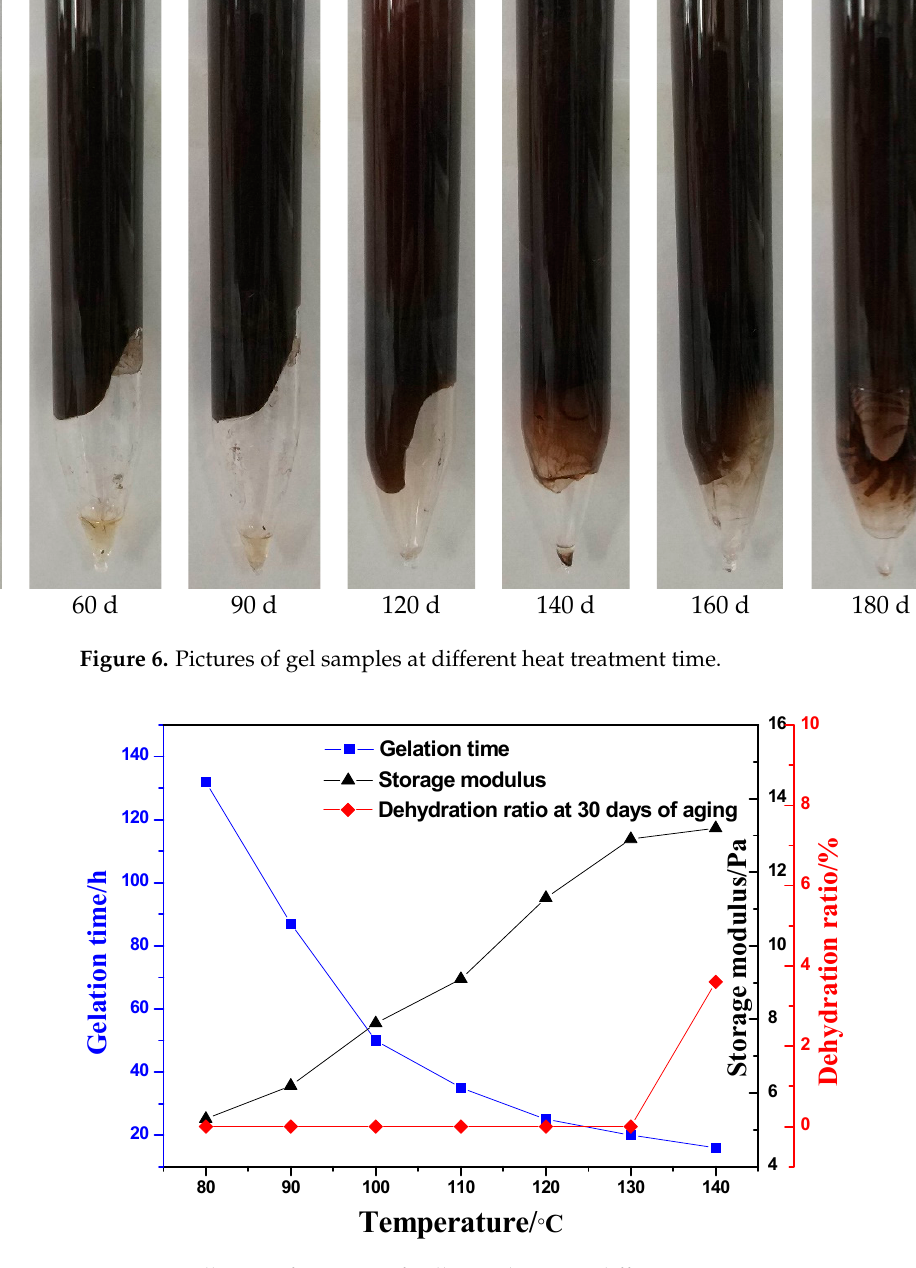
Figure 7. Gelling performance of gelling solution at different temperatures.